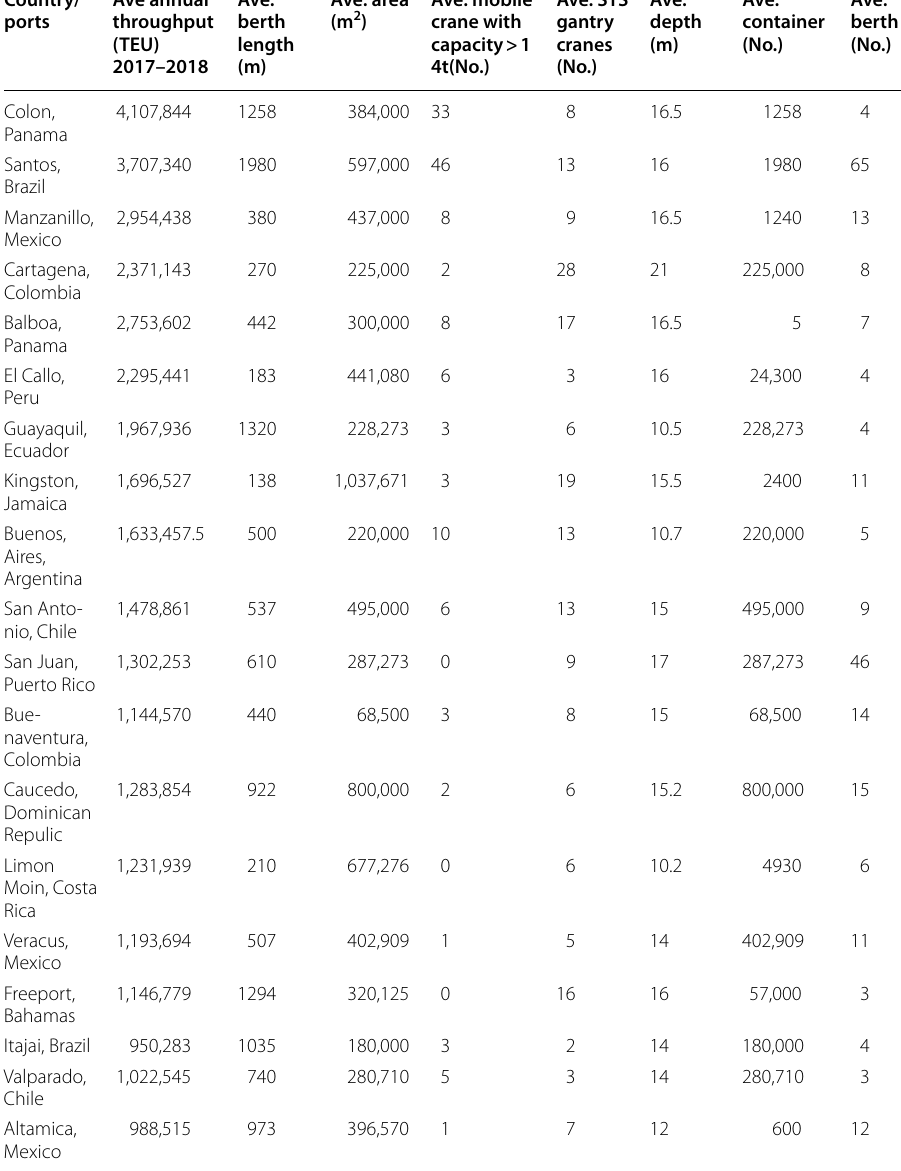
Table 10 Port characteristics. Average between 2017 and 2018 (Post-PCE-Era). Source : Own elaboration based on data from World Port Source Country/